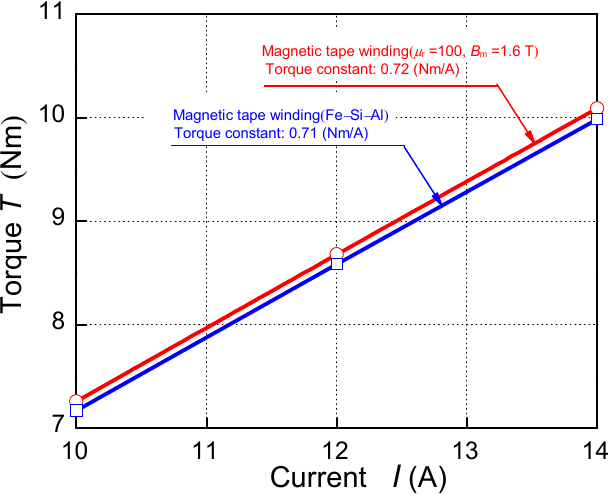
Figure 15. Torque–current characteristics of the motors described in Figure 14 ( N r = 10,000 rpm). Panels (a), (b), and (c) of Figure 16 compare the motor efficiencies, copper losses, and iron losses, respectively, as functions of ripple rate of the carrier harmonic (40 kHz). The efficiencies of both motor types decreased as the ripple factor increased from 0% to 100%. In the 10% to 50% region of ripple factors, the efficiency of the virtual tape-wrapped motor. At ripple rates above 50%, the efficiency of the Fe–Si–Al tape winding motor exceeded that of the ideal magnetic tape winding